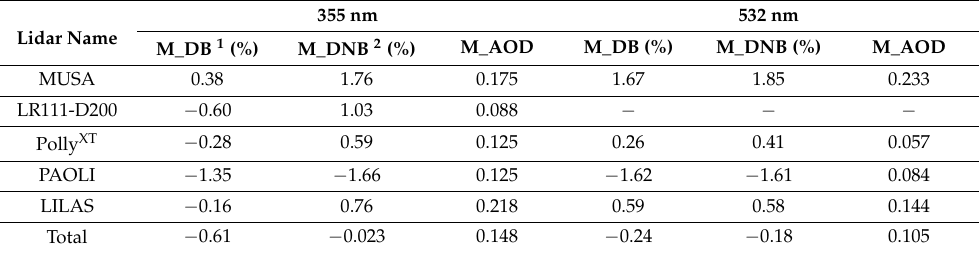
Table 6. The mean value of the mean relative deviation of the backscatter and mean relative deviation of molecular number density and mean aerosol load at two wavelengths. The backscatter was obtained by the Raman